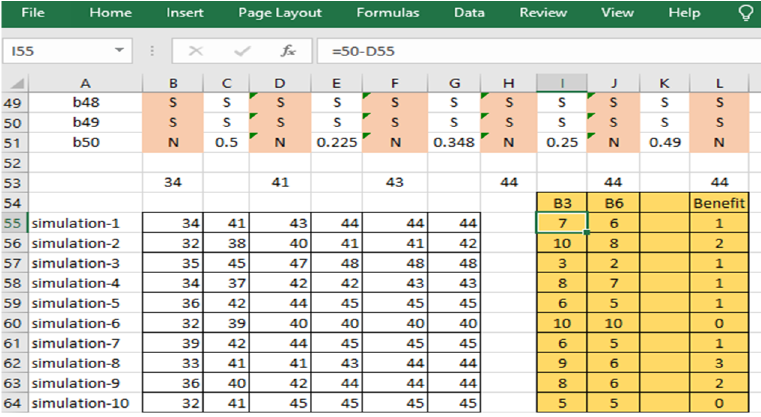
Figure 4. Formula used in column I of Excel sheet to find B3.